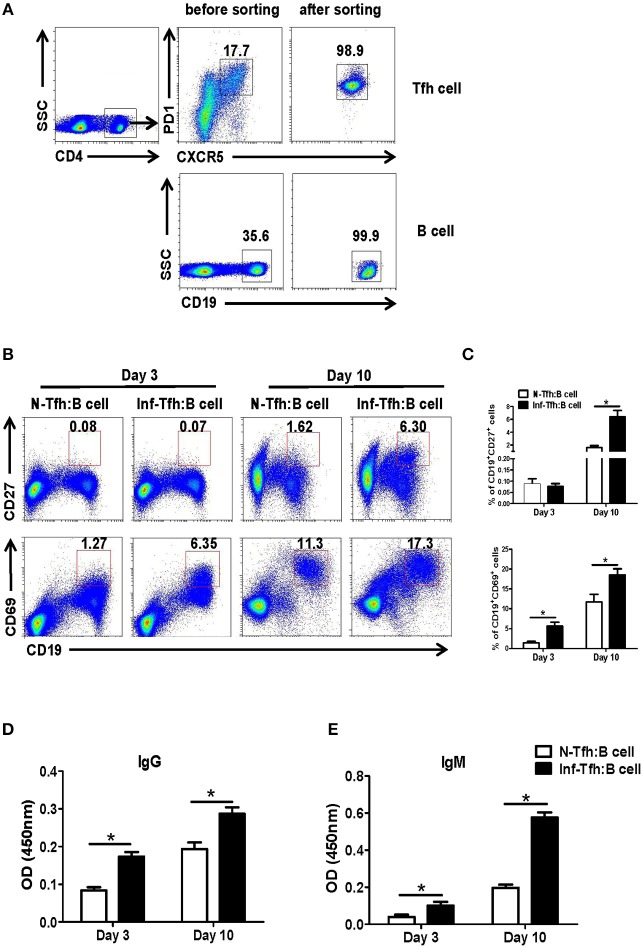
Function of Tfh cells from S. japonicum infected mice. (A) CD4+CXCR5+PD-1+ Tfh cells from normal or infected mice and allogeneic CD19+ B cells from normal controls are incubated at a ratio of 1:1 in RPMI1640 complete medium. (B,C) After 3 and or days of culture, the B cell subpopulations are examined based on surface phenotype. (B) Representative staining of CD27 and CD69 on B cells from naive mice at days 3 and 10 following co-culture with Tfh cells from normal and S. japonicum infected mice. (D,E) Mean ± SEM of one representative experiment. IgM and IgG concentration in the supernatant at day 3 or 10. Data are shown as mean ± SEM of 4–6 samples in each group from one representative experiment. *P < 0.05, **P < 0.01 compared with the corresponding controls; unpaired t-tests were used.